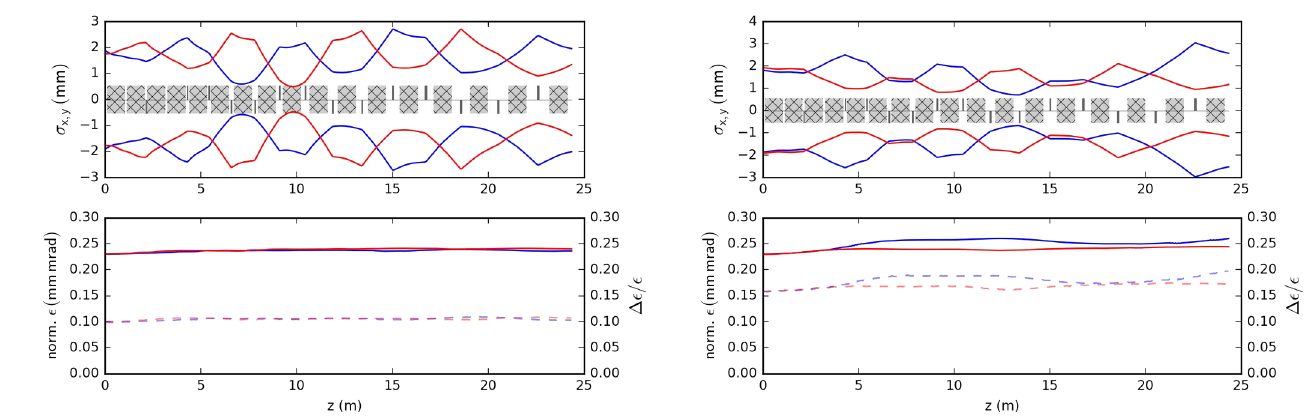
FIG. 8. rms beam envelope for the first pass using 6D waterbag initial distribution with 40 mA bunch current.